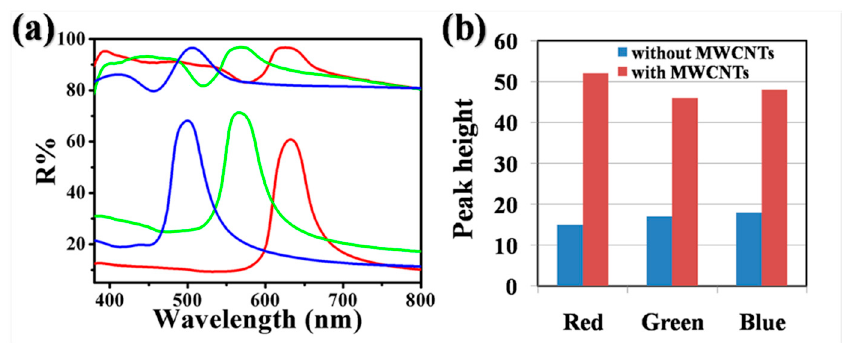
Figure 3. ( a ) Reflection spectra of the corresponding red, green and blue structural color films without MWCNTs (upper regions) and with MWCNTs (bottom regions); ( b ) The reflection peak intensity contrast of the structural color films without and with MWCNTs.